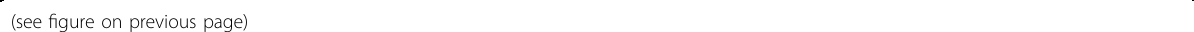
Fig. 5 RNF180 restored ADAMTS9 expression in GC cells by promoting DNMT3A protein ubiquitination and degradation. A The expression of RNF180 has a signi fi cant positive correlation with the expression of ADAMTS9, according to IHC of TMAs; B and the online DEPIA database. C The expression of ADAMTS9 was examined by PCR and western blotting method, after transfection with RNF180-overexpression plasmid. D The methylation levels of ADAMTS9 DNA promotor after transfection were examined by the MassARRAY analysis. E AGS and BGC-823 cells were transfected by RNF180-Flag plasmid or control vector. After 48 h, cells were treated with 100 mg/ml CHX at the indicated time point. The DNMT1, DNMT3A, ADAMTS9, and RNF180-Flag proteins were measured through western blotting method. F AGS and BGC-823 cells were transfected by RNF180-Flag plasmid or control vector. After 48 h, cells were incubated with 10 uM MG132 for 24 h. The DNMT1, DNMT3A, and RNF180-Flag proteins were measured through western blotting method. G RNF180-Myc plasmid or control vector was co-transfected transiently with the DNMT3A-Flag plasmid or control vector into HEK293T cells. After transfection 36 h, HEK293T cells were treated with 10 uM MG132 for 12 h. Then, co- immunoprecipitation assay was performed to pull down DNMT3A-Flag and RNF180-Myc proteins and the immunoprecipitated proteins were measured through western blotting method. H UB-HA and DNMT3A-Flag plasmids were co-transfected with RNF180-Myc plasmid into HEK293T cells. After 36 h, HEK293T cells were treated with 10 uM MG132 for 12 h. DNMT3A-Flag protein was immunoprecipitated and measured by western blotting method. The poly-ubiquitination level of DNMT3A was detected by anti-HA antibody. I Schematic diagram: RNF180 ubiquitinated DNMT3A by proteasome and restored ADAMTS9 expression through suppressing promotor methylation. ADAMTS9 inhibited MMP9, MMP19, and FN1 transcription and upregulated IGFBP1, and IGFBP3, which impaired the viability and migration behavior of